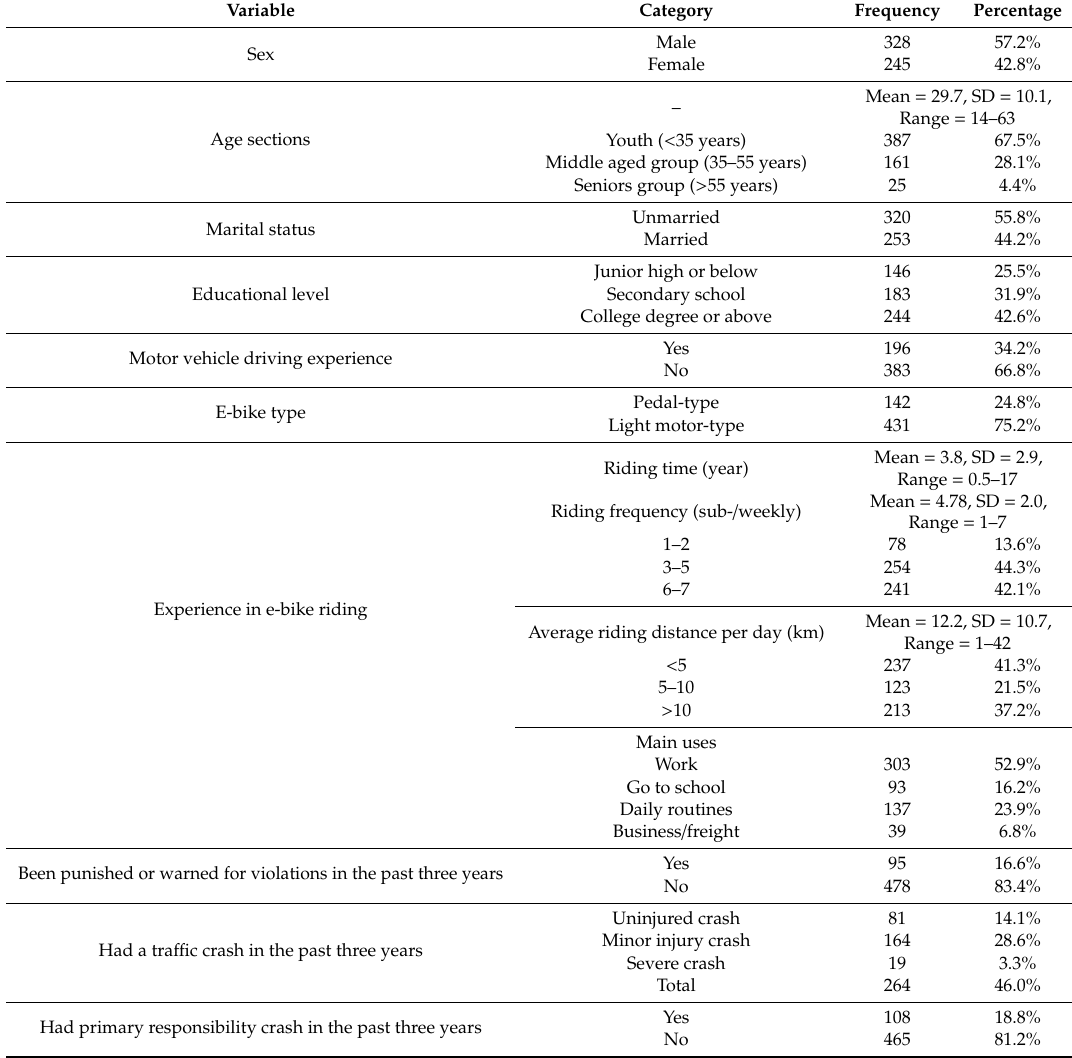
Table 1. Summary of respondents’ demographic information ( N =